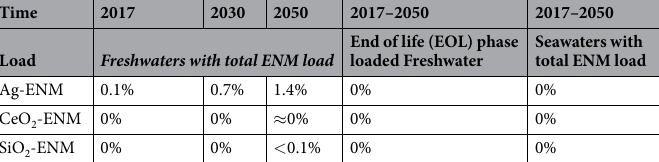
Table 5. Risk results for Ag-, CeO 2 -, and SiO 2 -ENM in waters (see also Fig. 6). Risks are predicted by comparing PEC (most probable range) of 2017, 2030, and 2050 to PSSD outputs. The values represent fresh water loaded from ENM use and EOL releases, as well as fresh water loaded only from EOL release and marine water loaded from use and EOL, as well as only EOL, release. The percentages combine the probability of critical PECs (PEC values higher than the minimal PSSD) with the one of critical PSSDs (PSSDs smaller than the highest PEC).